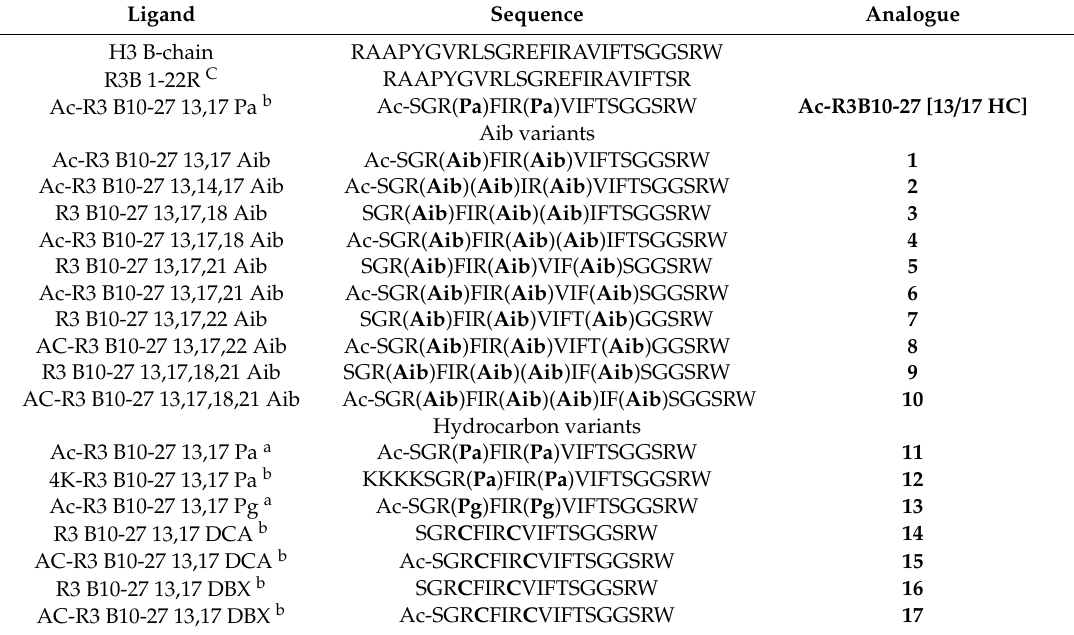
Table 1. Peptide sequences of novel relaxin-3 agonist